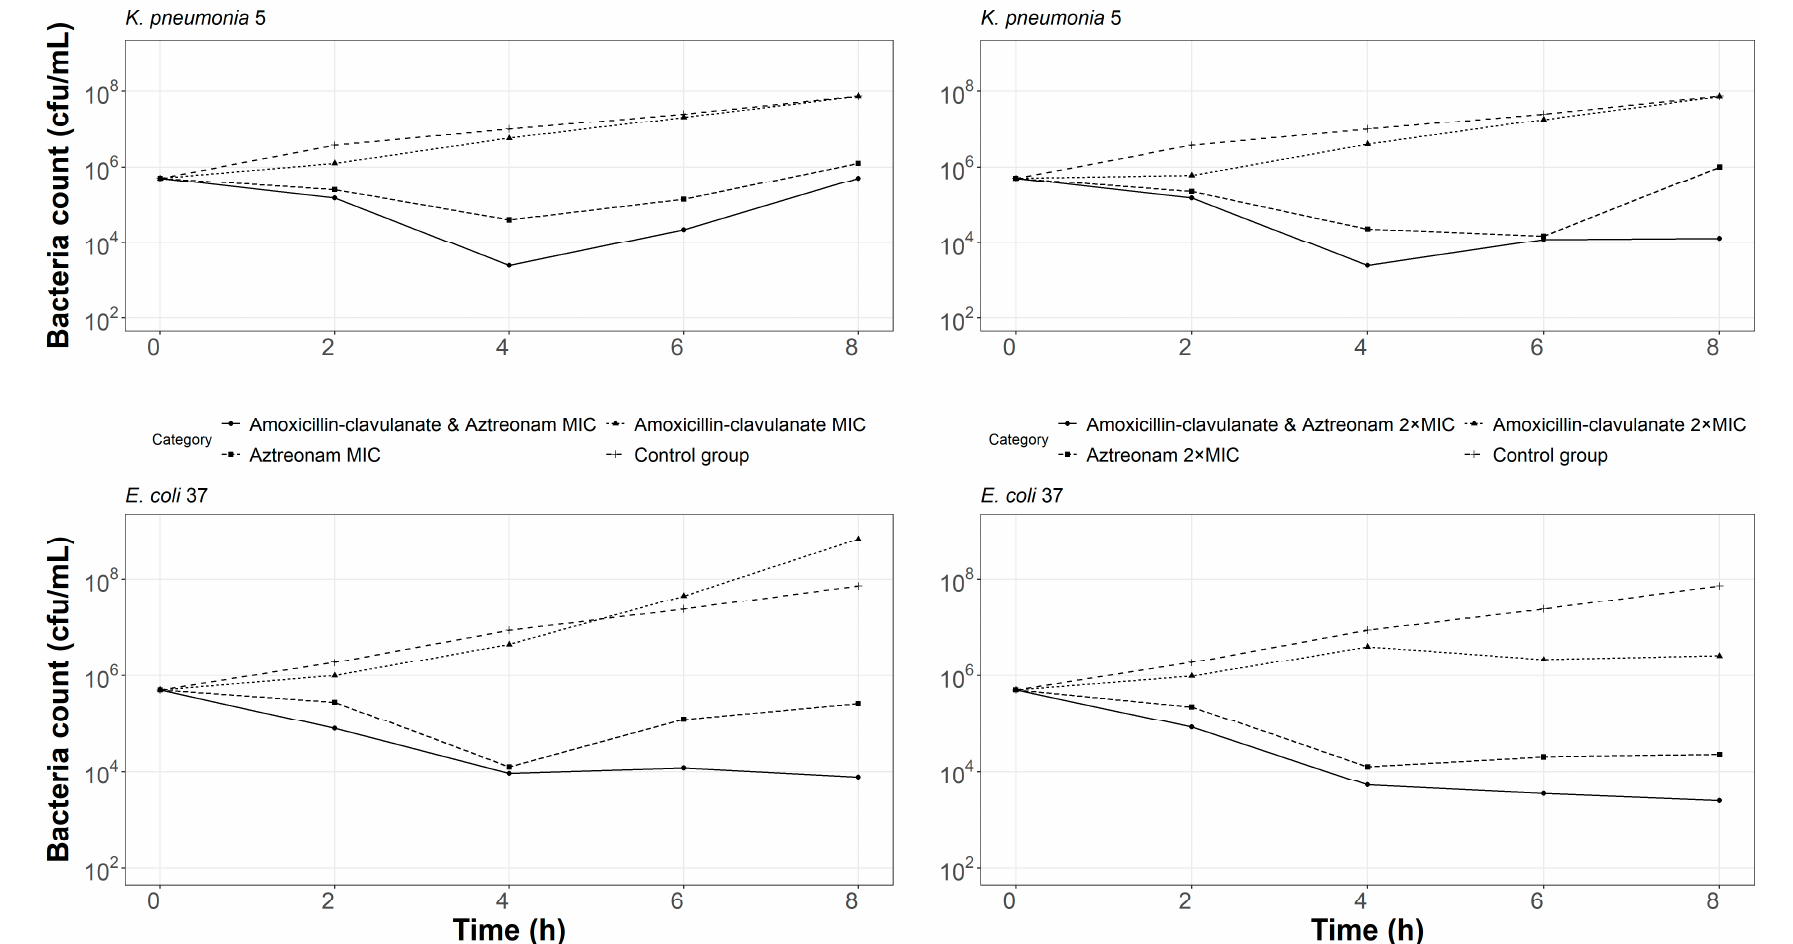
Figure 1. Static-concentration time–kill kinetics of amoxicillin/clavulanate and aztreonam alone and in combination at their respective MIC and two-fold MIC against K. pneumoniae 5 and E. coli 37.